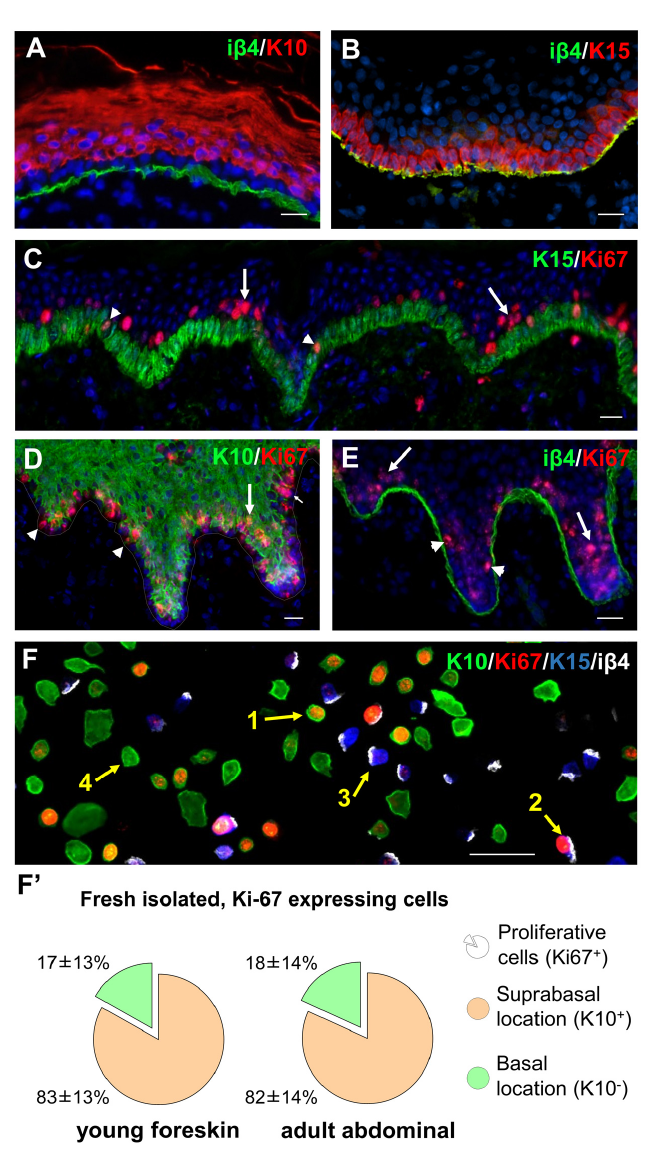
Figure 1. Suprabasal keratinocytes proliferate during homeostasis in human skin. Immunofluores- cence double-staining of normal human abdominal skin cryosections with antibodies against ( A ) i β 4 (green) and K10 (red), ( B ) i β 4 (green) and K15 (red), ( C ) K15 (green) and Ki67 (red), ( D ) K10 (green) and Ki67 (red), ( E ) i β 4 (green) and Ki67 (red) show that cycling keratinocytes can be found almost exclusively in suprabasal layers. ( F ) Cytospin centrifugation of freshly isolated keratinocytes and staining for Ki67 (red) and K10 (green) to allow for quantification of proliferating cells and their assignment to the basal or suprabasal cell pool. In this picture, cells were stained additionally for K15 (blue) and i β 4 (white) to double-check the identity of basal cells. Yellow arrows point to four different cell types: proliferating suprabasal cells (1), proliferating basal cell (2), quiescent basal cell (3) and quiescent suprabasal cell (4). Single colour images and magnification can be seen in the sup- plementary Figure S1. ( F’ ) The statistical analysis of the original intra-epidermal localization of freshly isolated Ki67 positive keratinocytes from foreskin biopsies ( n = 6) as well as from abdominal